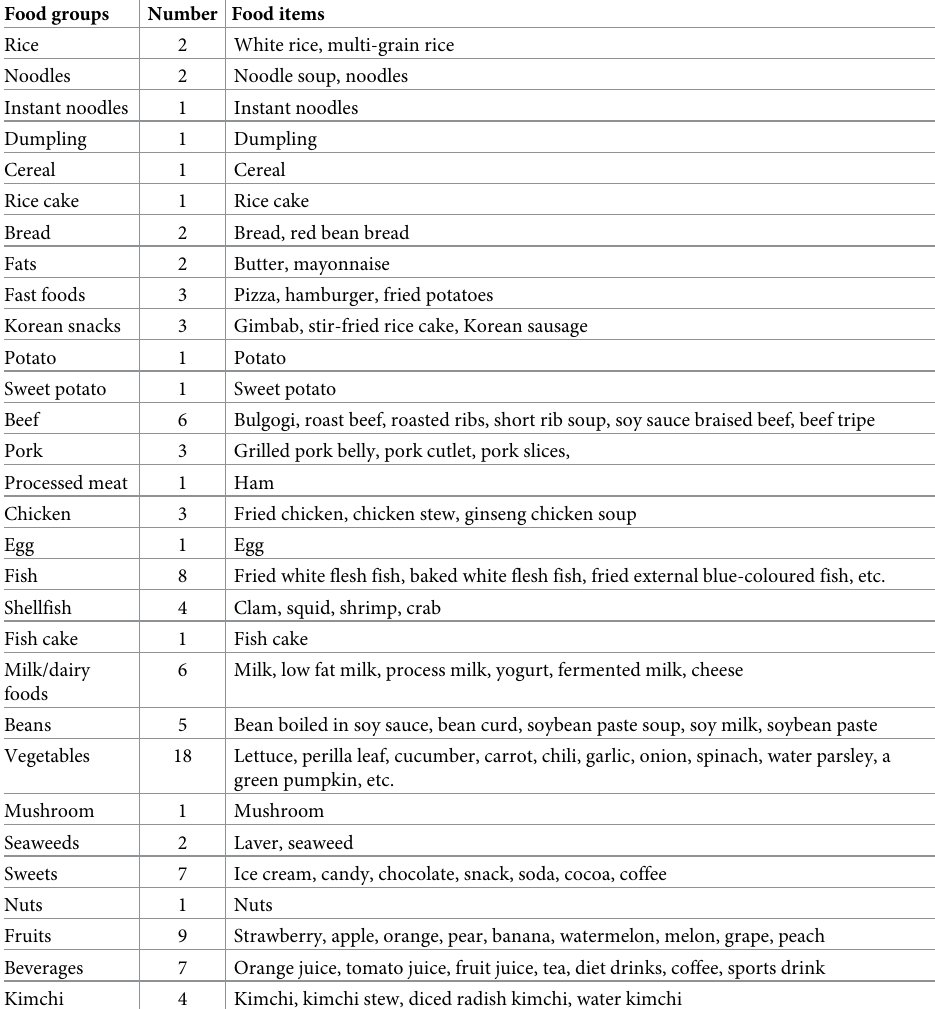
Table 1. Lists of food items in a dish-based semi-quantitative food frequency questionnaire. Food